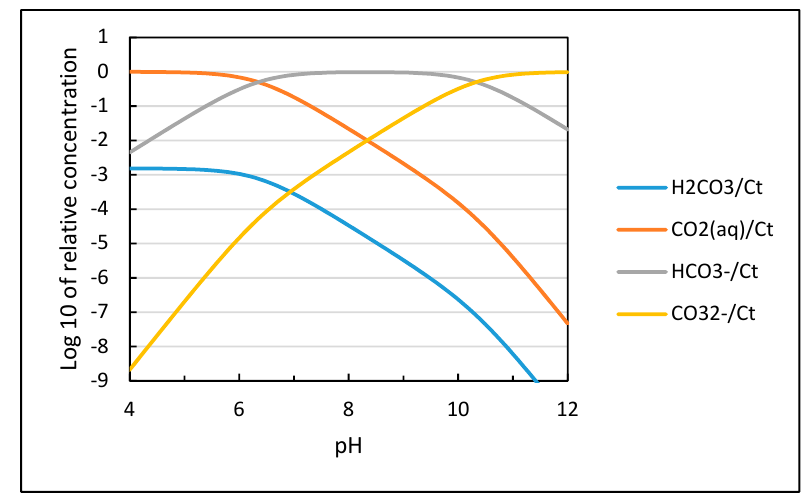
Figure 3. Distribution of solute species versus pH for a closed aqueous carbonate system at 25 °C and zero ionic strength plotted based on their equilibrium constants [13].